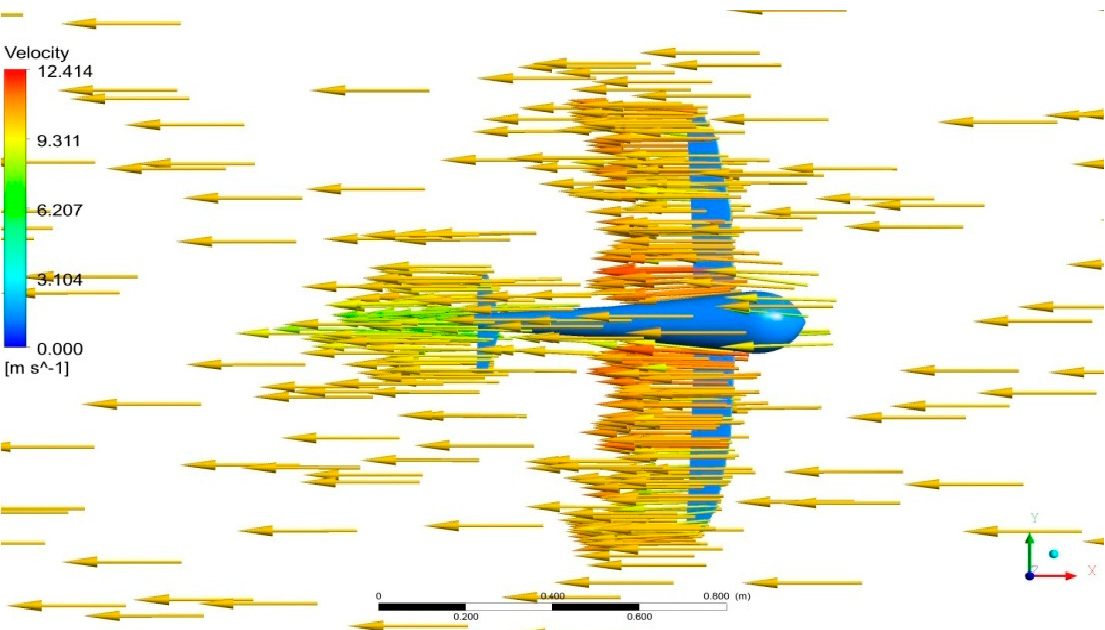
Figure 15. Aerodynamic Pressure variations on UAV when flying above the ocean.